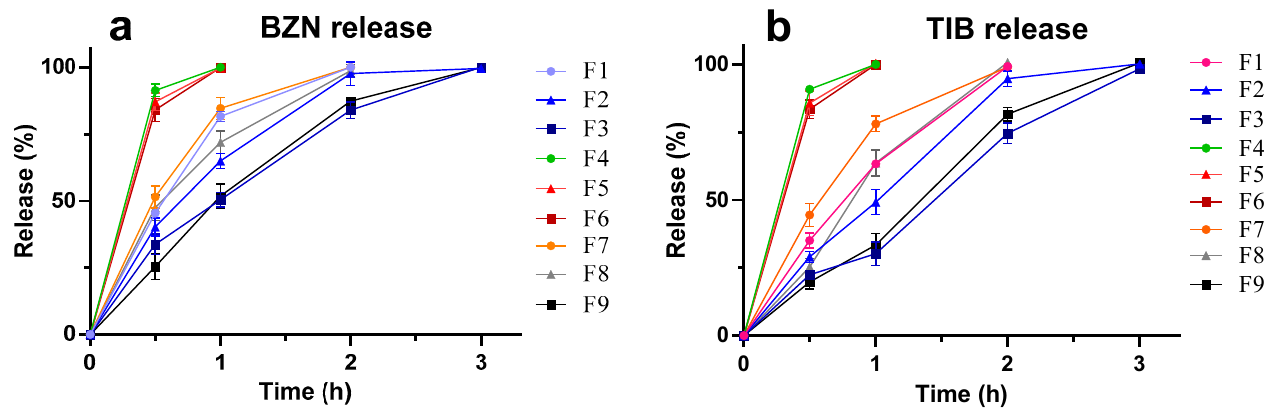
Figure 3. In vitro drug release of smart mucoadhesive buccal formulations for ( a ). BZN and ( b ). TIB.